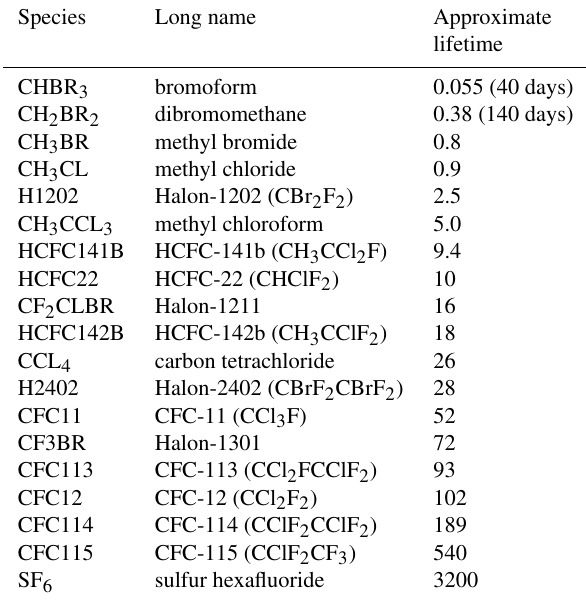
Table 2. Halogenated compounds in JAM002 with relevance for stratospheric ozone chemistry and their approximate lifetimes in years (Miller et al., 1998; Liang et al., 2010; WMO, 2014; Harri- son et al., 2016).